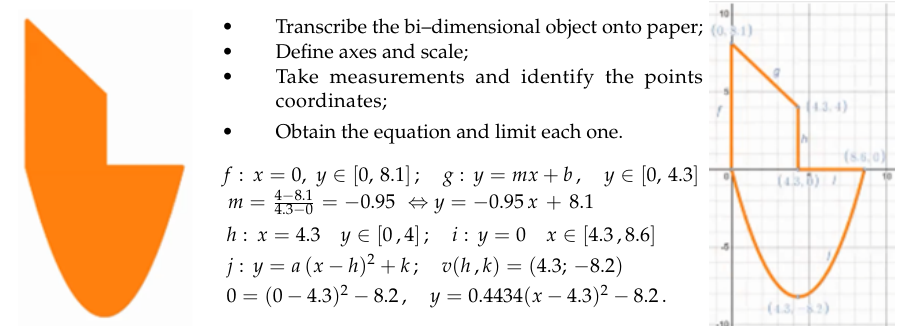
Figure 4. Q2—Desmos use—function and graph, example 1.